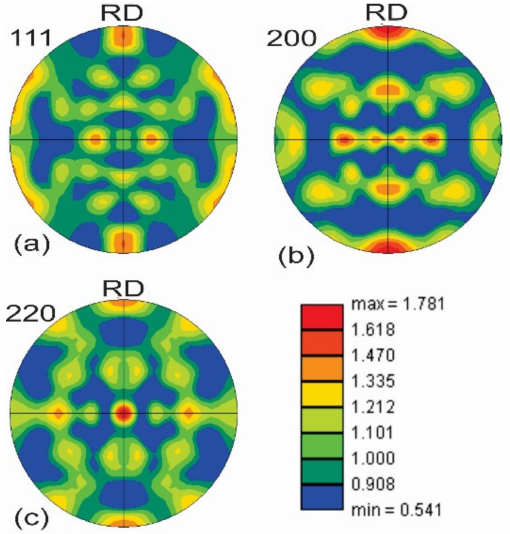
Figure 14. ( a ) { 111 } , ( b ) { 100 } , and ( c ) { 110 } PFs of the as-received tubes at min side. The maximum intensity of PFs is approximately